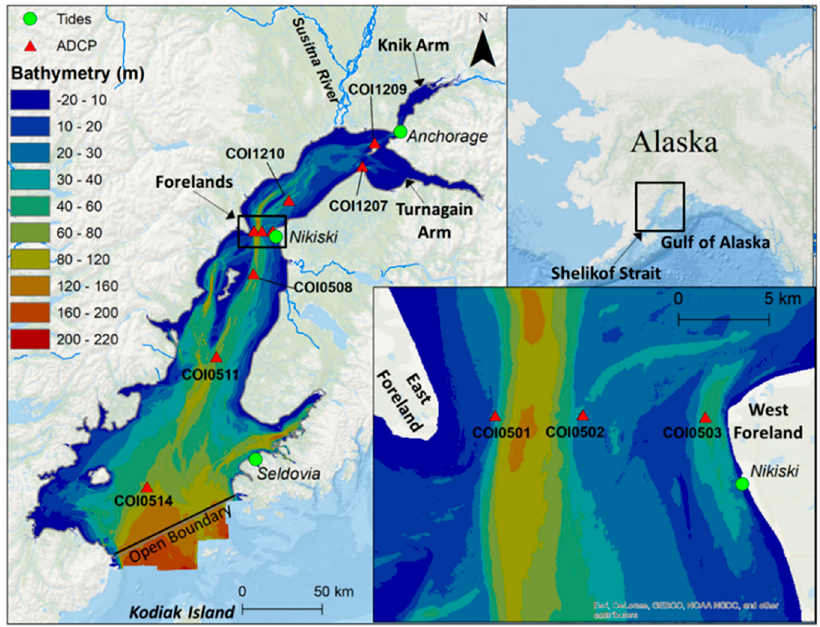
Figure 1. A map showing the study site, Cook Inlet in Alaska, USA, and selected field monitoring stations. The bottom-right inset provides a zoom-in view of the bathymetric features and field observational stations near the Forelands.